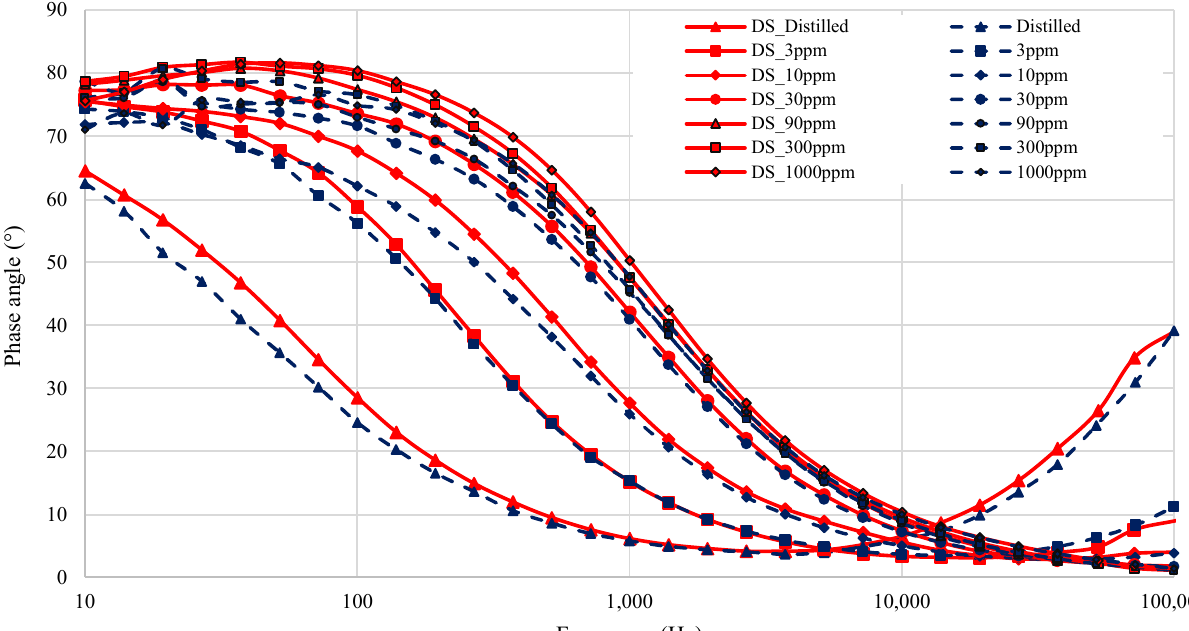
Figure 7. Figure showing phase angle of all seven solution measurements before calibration. All DropSens µStat-i 400s measurements are in red, with low-cost impedance measurements in blue.